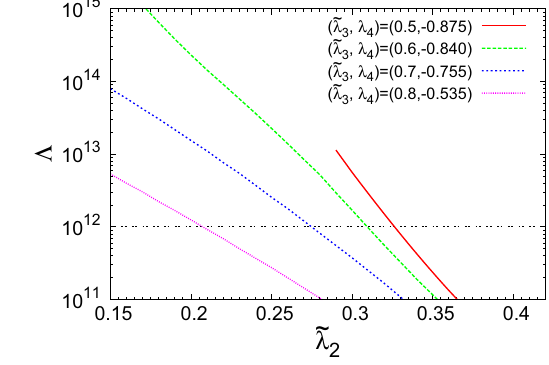
Fig. 2 Left panel: example points in the ( ˜ λ 3 ,λ 4 ) plane are plotted condition for the vacuum stability in (15). Right panel: a cut-off scale (cid:5) as a function of ˜ λ by the crosses, at which the η R relics can explain the DM abundance 2 , which is fixed as a value at M Z . Each line is (cid:22) h 2 = 0 . 12. ˜ m 2 = 1 TeV and ˜ λ = 5 . 4 × 10 − 3 are assumed. The plotted for four points marked by the crosses in the left panel where η 5 (cid:22) h 2 = 0 . 12 is region above each line fixed by a listed value of ˜ λ 2 satisfies the last